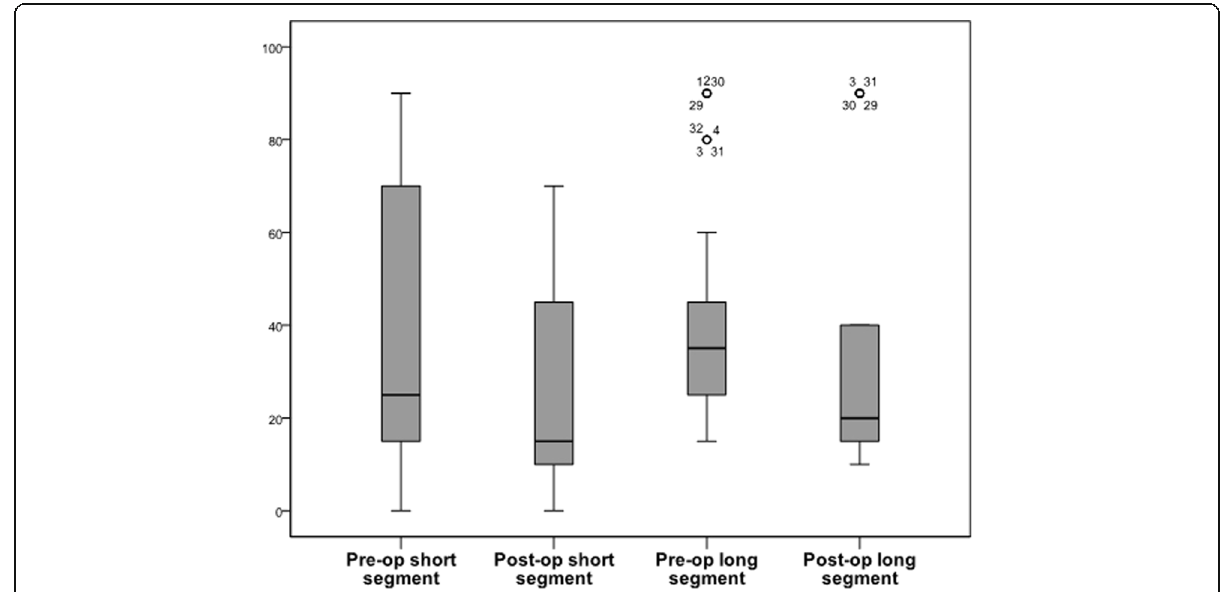
Fig. 3 The changes in the ODI in both groups at the first year post-op